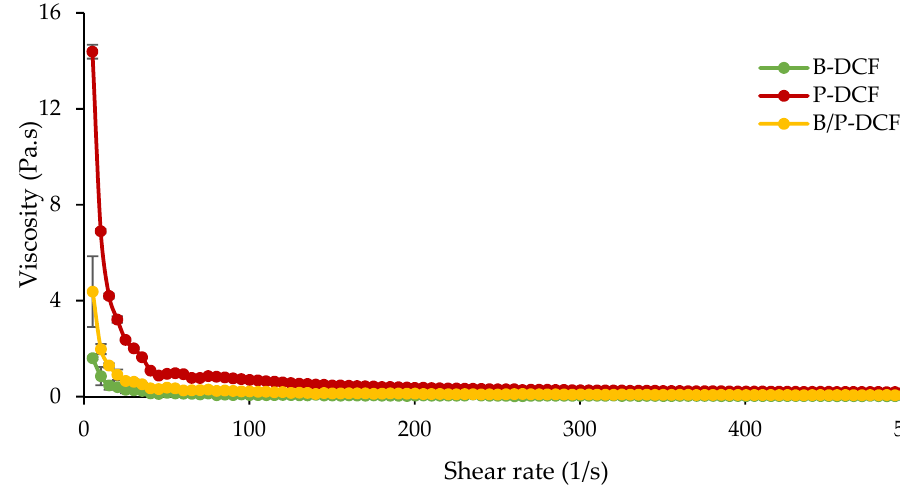
Figure 2. Viscosity behavior of B-DCF, P-DCF, and B/P-DCF hydrogels in the range of 10–500 1/s at 32 °C (mean values ± s.d.; n = 3).